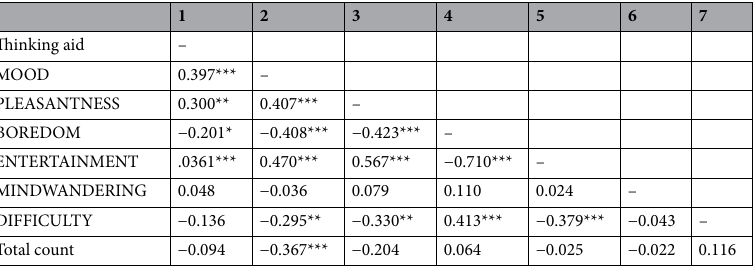
Table 5. Spearman’s rank-based correlations between thinking aide conditions, mood change, ratings of the thinking period, and counts of self-administered shocks. Thinking aide condition (−1 = negative, 0 = control, + 1 = positive), * p < .05, ** p < .01, *** p <